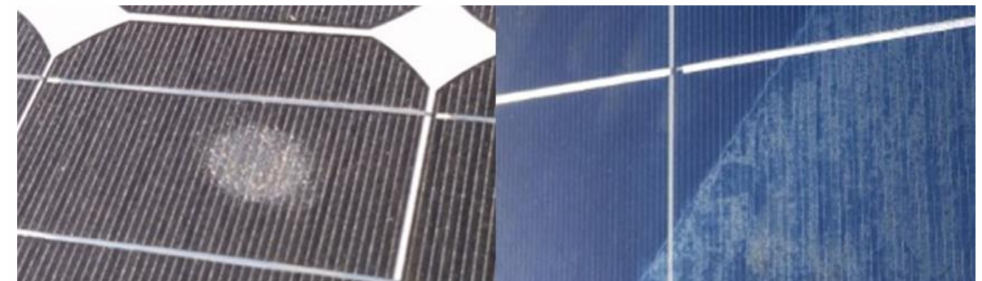
Figure 9. PV module with a delamination.